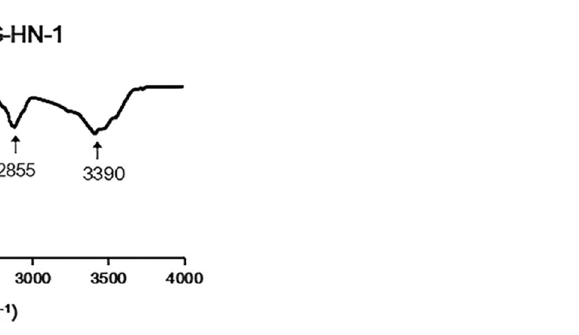
Figure 2. The FTIR spectra of